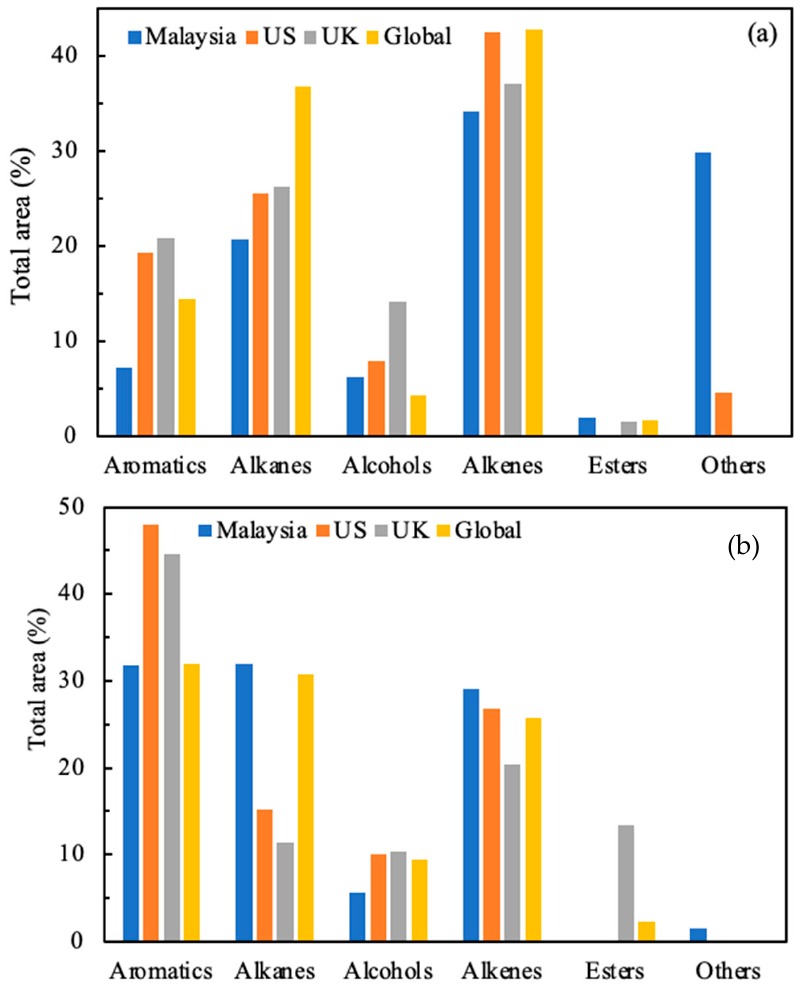
Figure 8. Identified compound for ( a ) thermal pyrolysis of mixed plastic composition and ( b ) identified compound for catalytic pyrolysis of mixed plastic composition using 1 g bentonite.